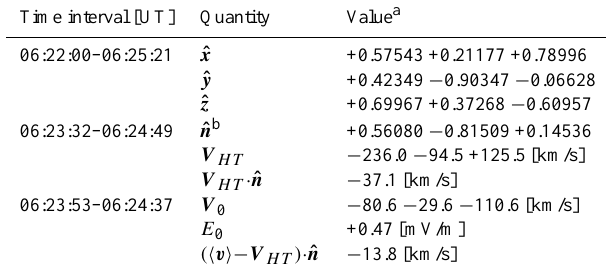
Table 1. C3 basic parameters for 5 July 2001